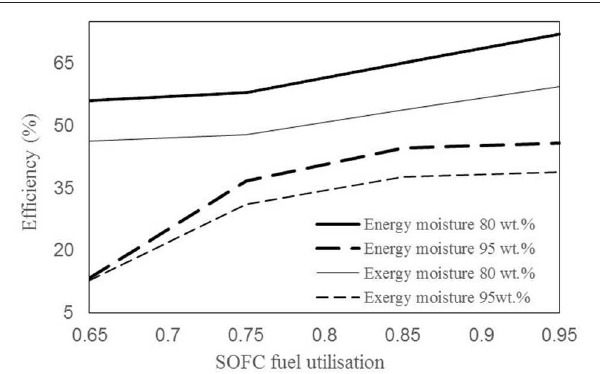
Figure 6A illustrates the contribution of each process unit in the exergy destruction at 80 and 95 wt.% biomass